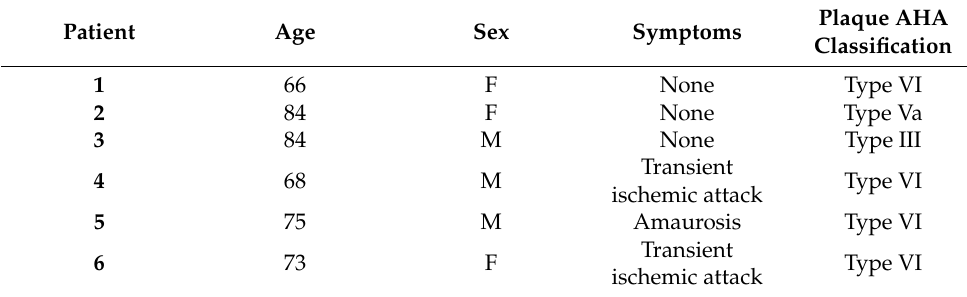
Table 3. Patients and plaques